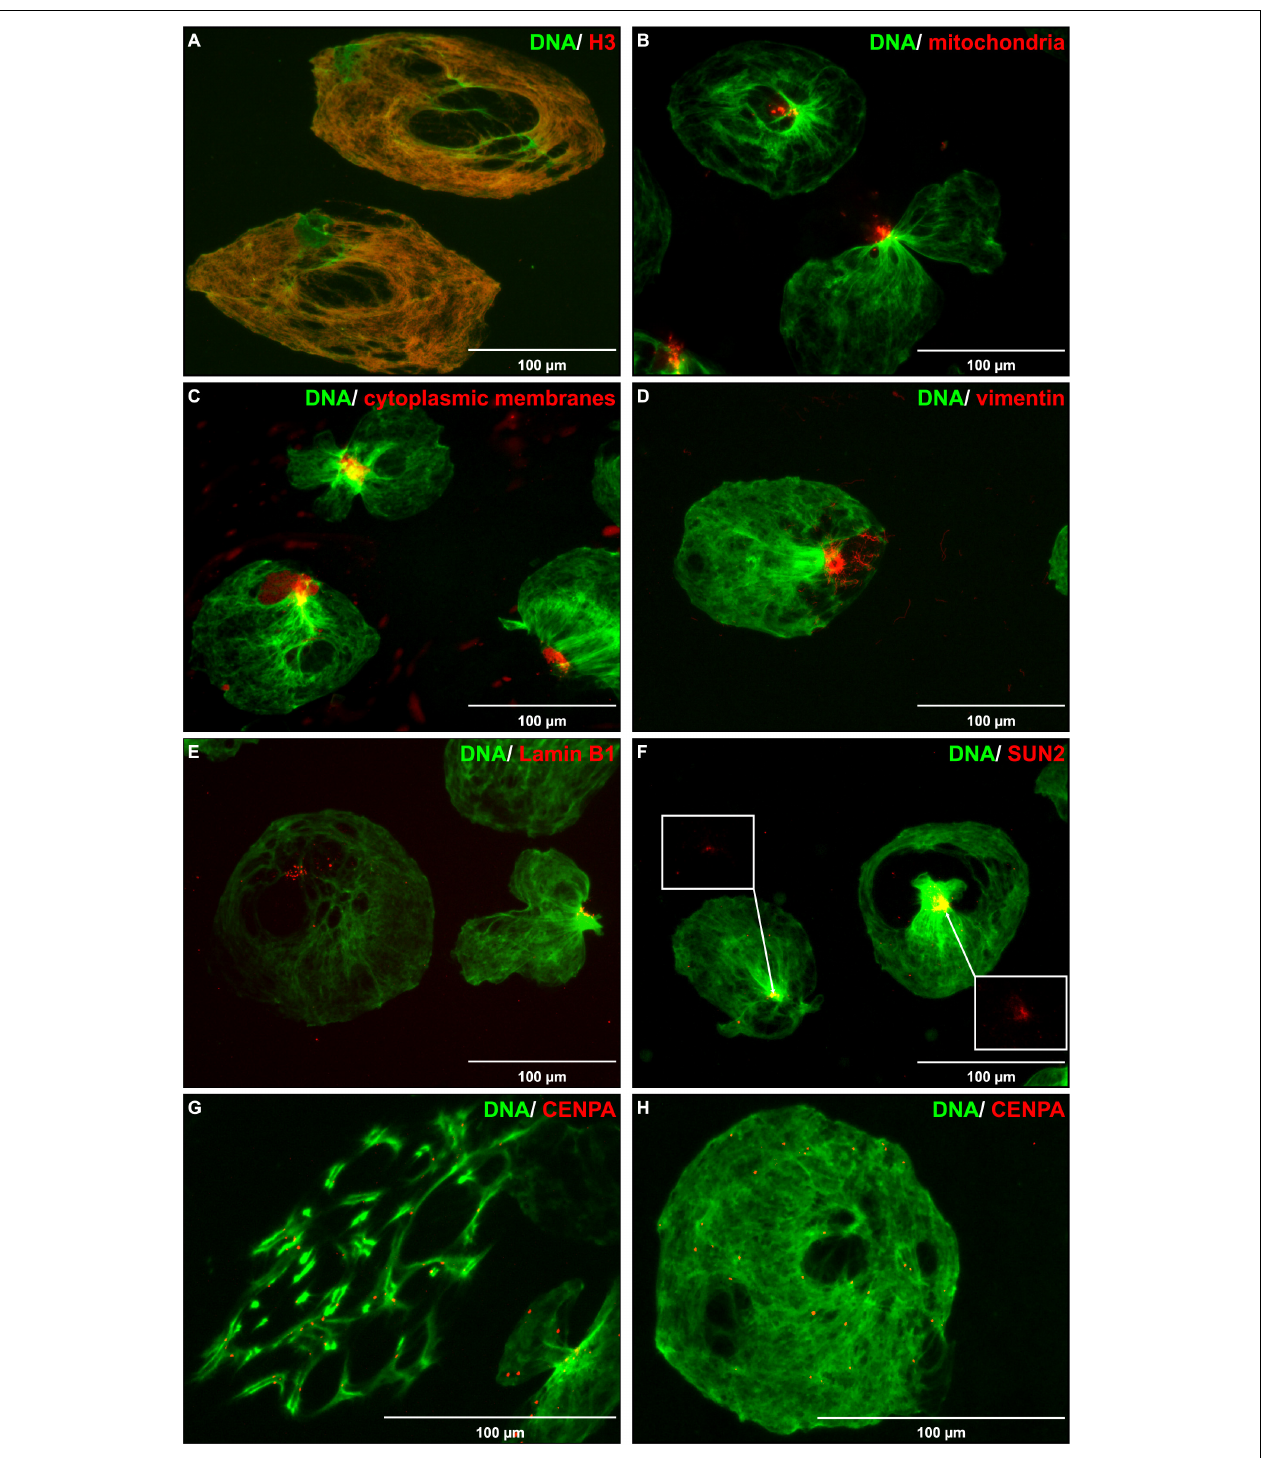
FIGURE 6 | Staining of DNA along with cellular components. Microscopy images (40 × objective) of extracellular DNA (green) released from Nalm-6 cells, immobilized on glass slides, and stained for different cellular components (red). (A) Immunostaining of Histone H3. (B) Staining of mitochondria using Mitotracker. (C) Membrane labeling using CellBrite Cytoplasmic Membrane Dye. (D) Immunostaining of Vimentin. (E) Immunostaining of Lamin B1. (F) Immunostaining of SUN2. (G) Immunostaining of Centromere protein A (CENPA) after nocodazole treatment of cells prior exposure to serum-free conditions. (H) Immunostaining of CENPA without prior nocodazole treatment. Scale bars equal 100 µ m. In panel (F) , white boxes highlight SUN2 staining.